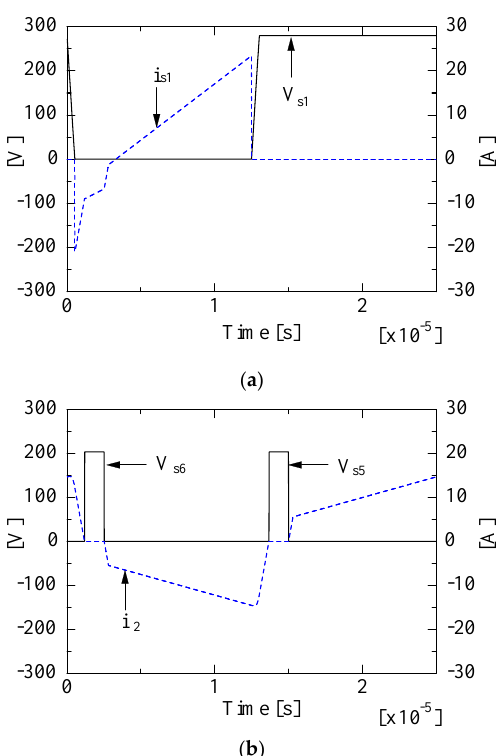
Figure 4. Steady operation waveform by simulation in the case of rated output (duty factor = 0.9). ( a ) Primary-side switch voltage V s1 and current i s1 . ( b ) Secondary-side switches voltage and secondary-side current.